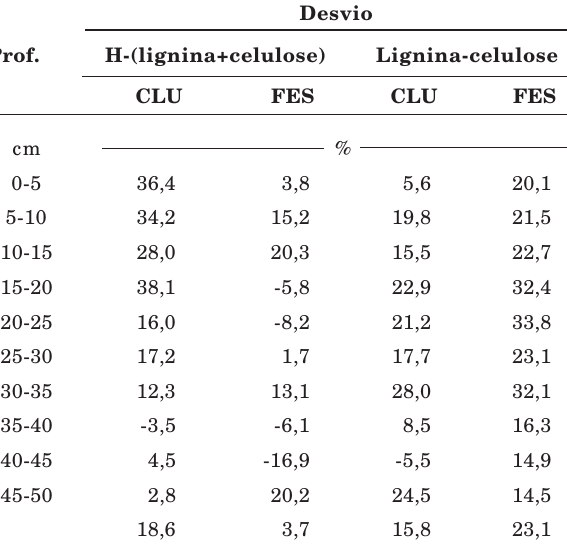
sob Campo Limpo Úmido (CLU) e sob Floresta